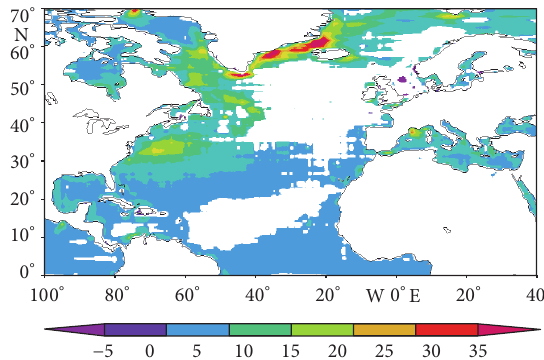
Figure 3: Annual average wind power density and its long-term trend in the North Atlantic. Figure 4: Long-term annual trend of wind power density in the North Atlantic, unit: (W/m 2 )/yr. Only areas significant at the 95% level are